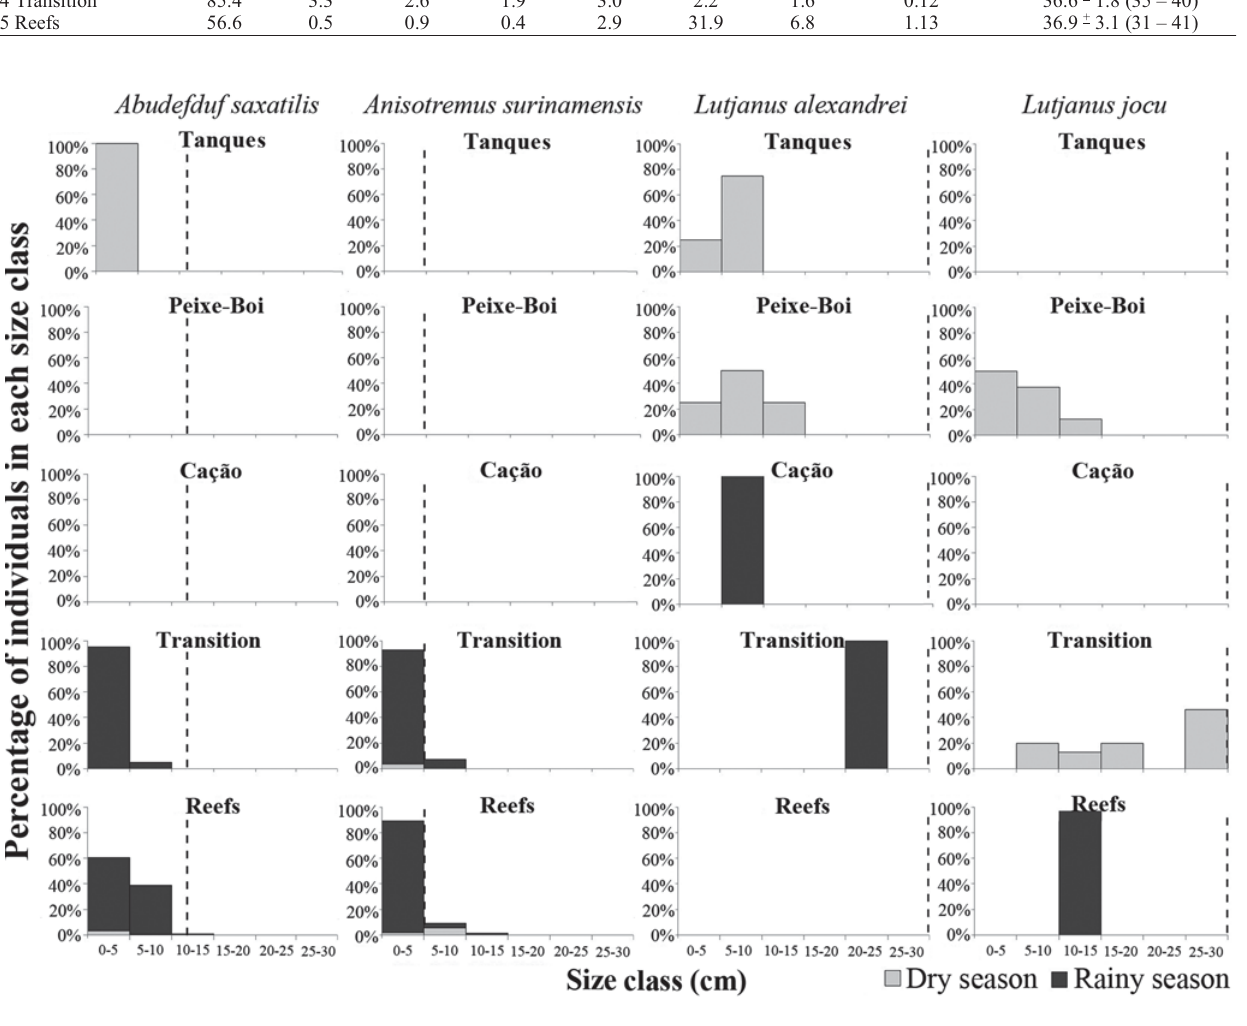
Fig. 2. Ontogenetic patterns of habitat use in Abudefduf saxatilis , Anisotremus surinamensis , Lutjanus alexandrei , and L. jocu along the sub-areas of Mamanguape Mangrove-Reef system, NE Brazil, showing an increase in individual size classes from the Estuarine to the Reef zone. Mann Whitney U Test showed significant size differences between all sub-areas (for A. saxatilis , Transition vs. Reefs: U = 491, Z = -6.02, p = 0.00; for A. surinamensis , Transition vs. Reefs: U = 1338, Z = -6.83, p = 0.00; for L. alexandrei , Peixe-Boi vs. Transition: U = 0.00, Z = -3.39, p = 0.00; and Tanques vs. Transition: U = 0.00, Z = -2.92, p = 0.00; for L. jocu , Peixe-Boi vs . Transition: U = 7.5, Z = -3.38, p = 0.00), except between Tanques and Peixe-Boi for L. alexandrei (U = 65, Z = 0.76, p =